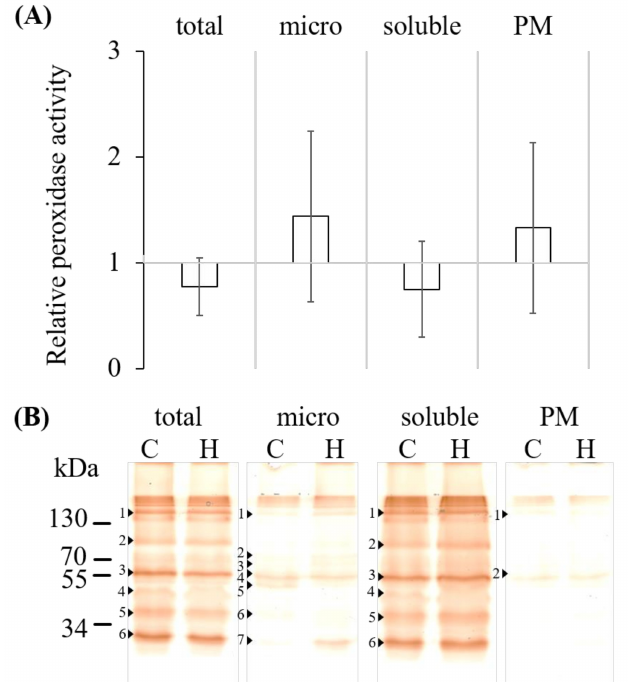
Figure 2. Total guaiacol peroxidase activity and abundance of control and hypoxia-stressed maize roots. Non-stressed (C) and 24 h hypoxia-stressed root samples (H) were divided into total extracts (total) and the sub-proteomes soluble proteins, microsomes (micro), and plasma membranes (PM). ( A ) Using the substrate guaiacol, the total activity was detected spectrophotometrically of the cellular fractions. Data of the stressed samples were related to the controls (three biological and three technical replicates). ( B ) The abundances of guaiacol peroxidases were detected after separation by 11% polyacrylamide gels of the cellular fractions. Peroxidase bands (nos. 1-7) were marked by arrows. Shown is one representative replicate.